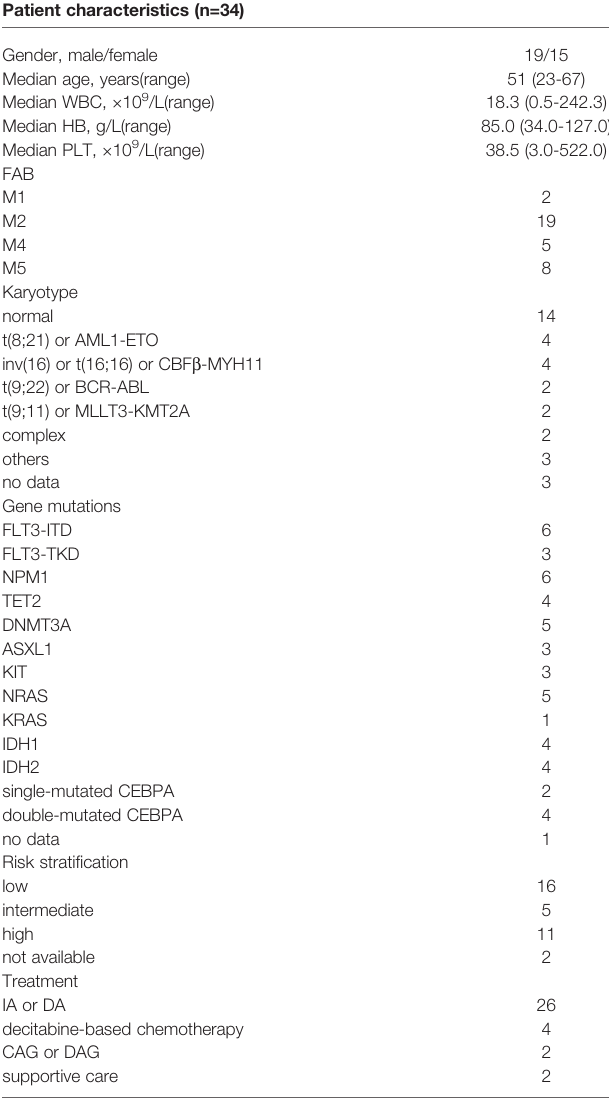
TABLE 1 | Demographic and clinical data of AML patients. Patient characteristics